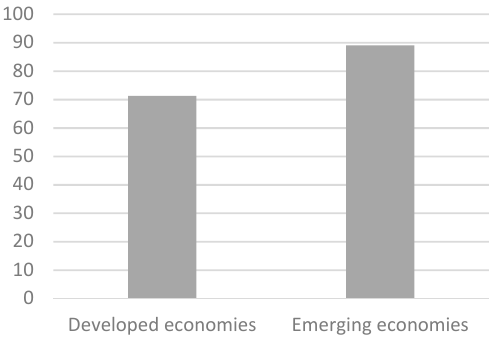
Figure 8. The purpose of Facebook usage in business .